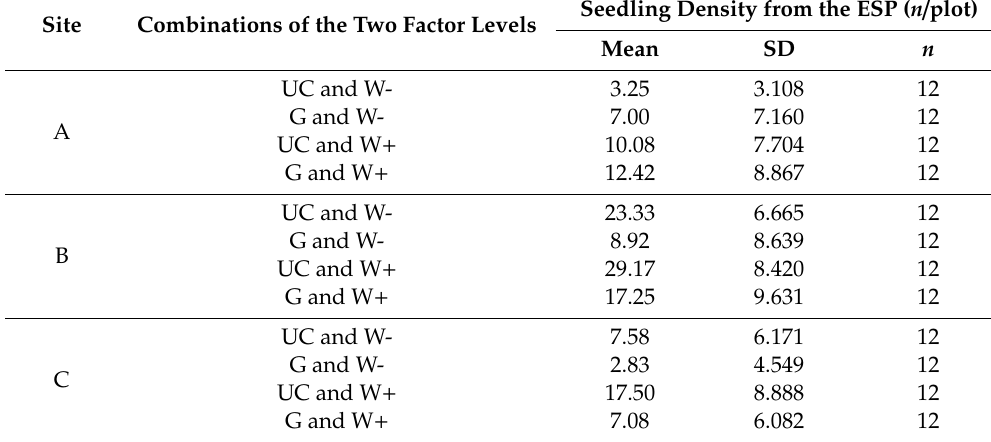
Table 10. Mean density of P. brutia seedlings which survived from the ESP (December 2009) in the plots of each of the combinations of the two factor levels in each of the three sites. Seedling Density from the ESP ( n / plot) Site Combinations of the Two Factor Levels Mean SD n UC and W- 3.25 3.108 12 G and W- 7.00 7.160 12 A UC and W + 10.08 7.704 G and W + 12.42 8.867 UC and W- 23.33 6.665 G and W- 8.92 B UC and W + 29.17 G and W + 17.25 9.631 UC and W- 7.58 6.171 G and W- 2.83 4.549 C UC and W + 17.50 8.888 G and W + 7.08